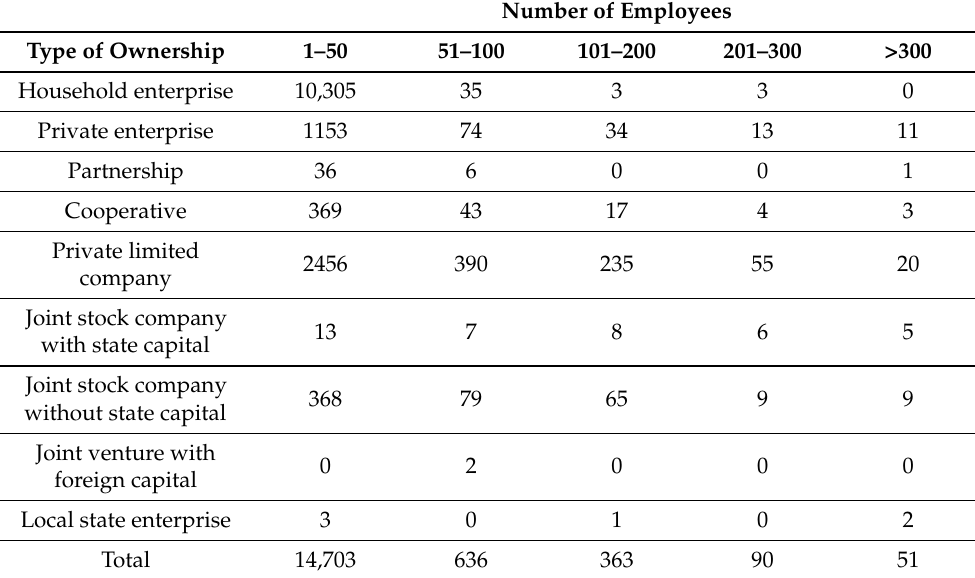
Table 2. Distribution of Firm Observations by Number of Employees and Type of Ownership (unbalanced